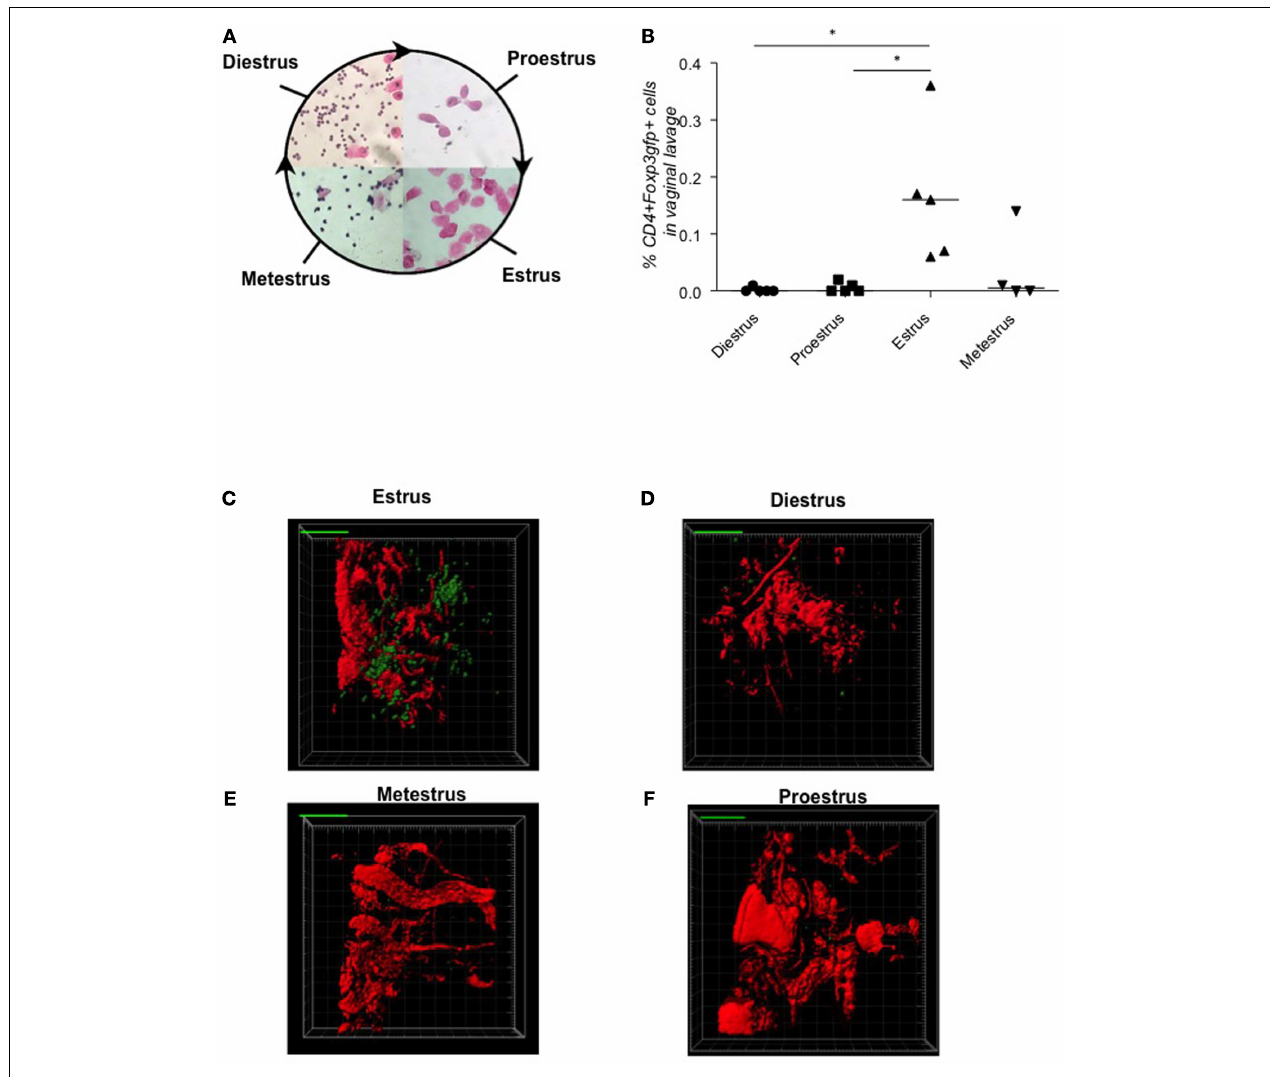
dot plots with medians and were analyzed by Mann–Whitney- U test (* P ≤ 0.05). Snap shots of two-photon microscopy videos of Foxp3 GFP positive cells in uterus performed at different phases of the cycle (C) estrus phase; (D) diestrus phase; (E) metestrus phase; (F) proestrus